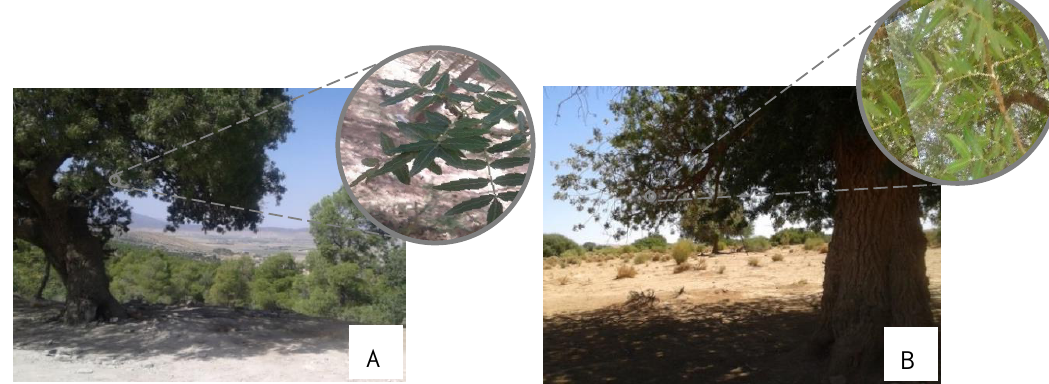
Figure 4. Pistacia atlantica Desf. atlantica tree and leaves in regions of Batna ( A ) and Bechar ( B ) (September 2015). Photos: Labdelli A.